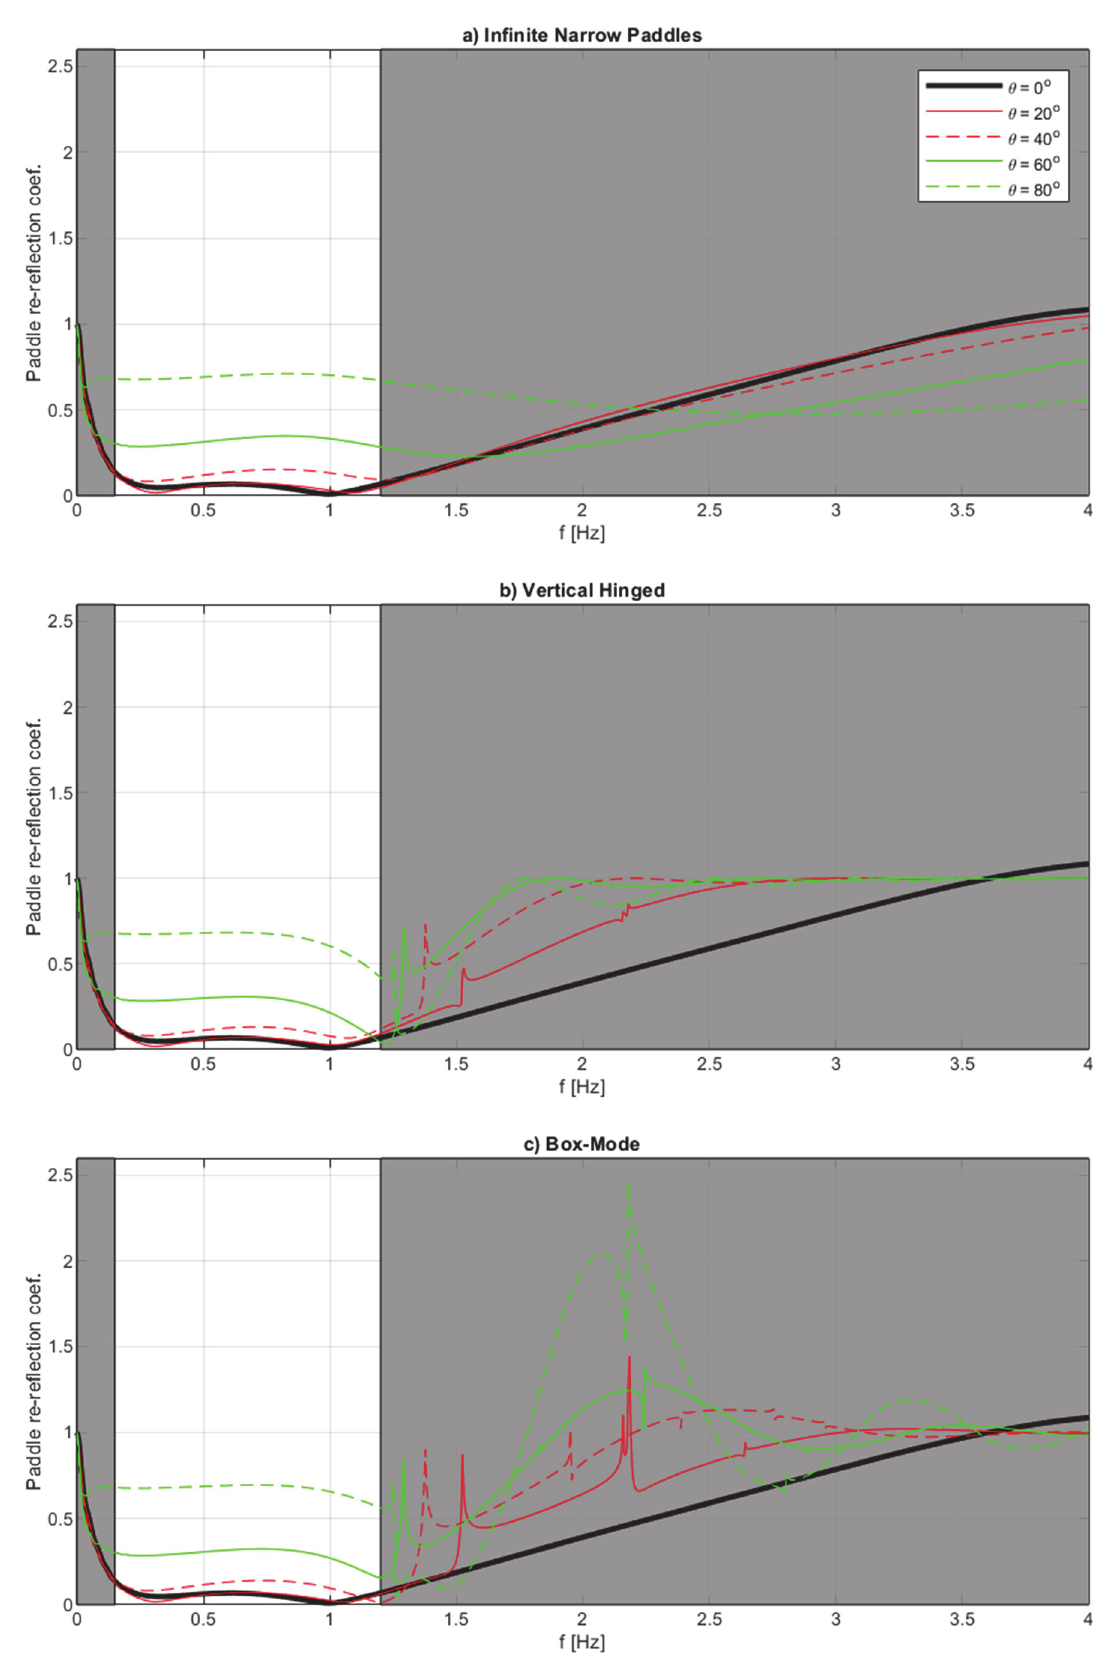
Figure 4. Same as Figure 3 but for wave gauges with a small gap to the paddle face ( d wg = 3 cm).